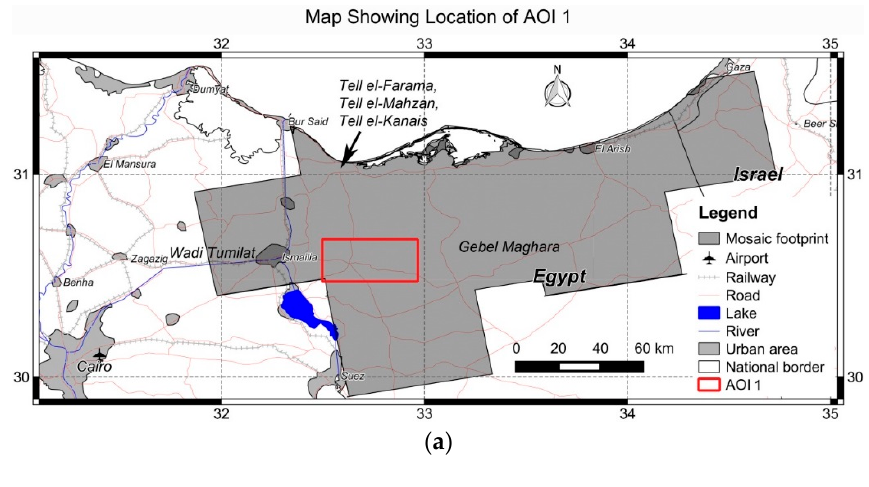
Figure 7. Cont. Figure 7.